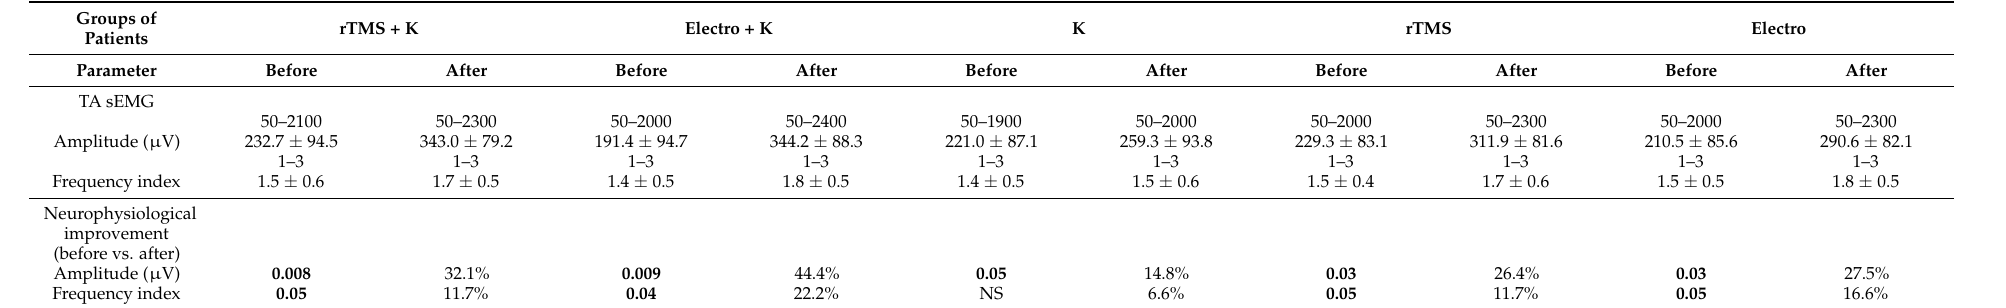
Table 2. A summary of the sEMG parameters measured from the anterior tibialis muscles (cumulative data for the right and left sides) in the iSCI patients belonging to five therapeutic groups before and after the applied treatment. p —significant differences are marked in bold. %—the percentage of